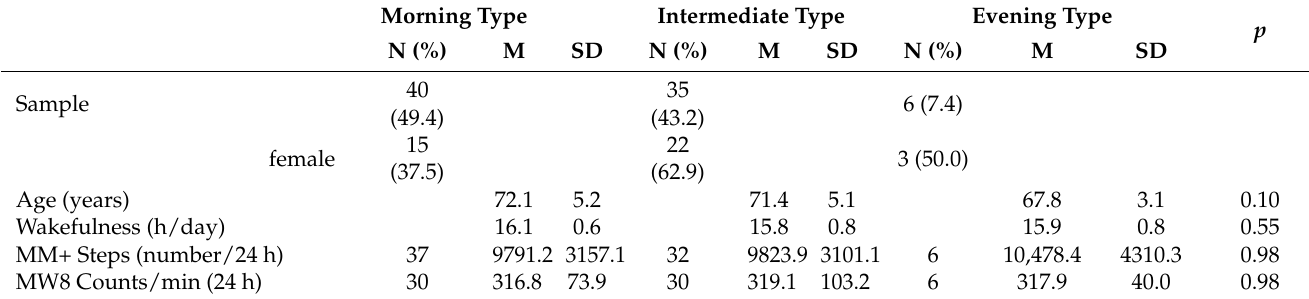
Table 2. Sample characteristics of self-estimated chronotype